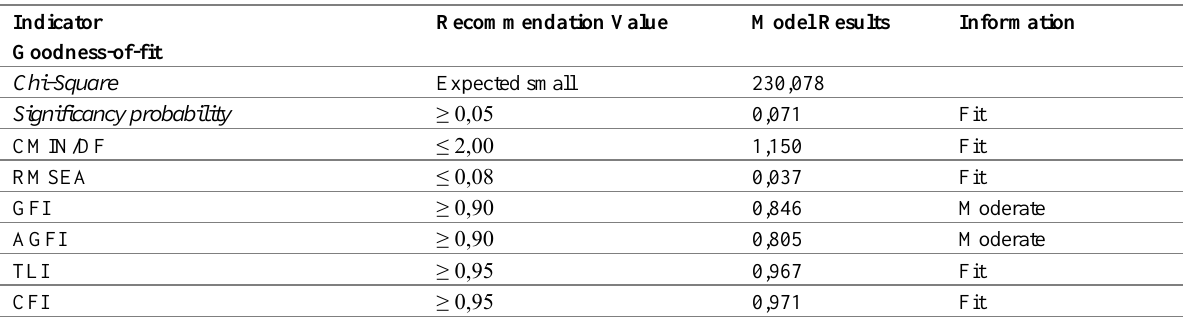
Table 1: Goodness of Fit SEM